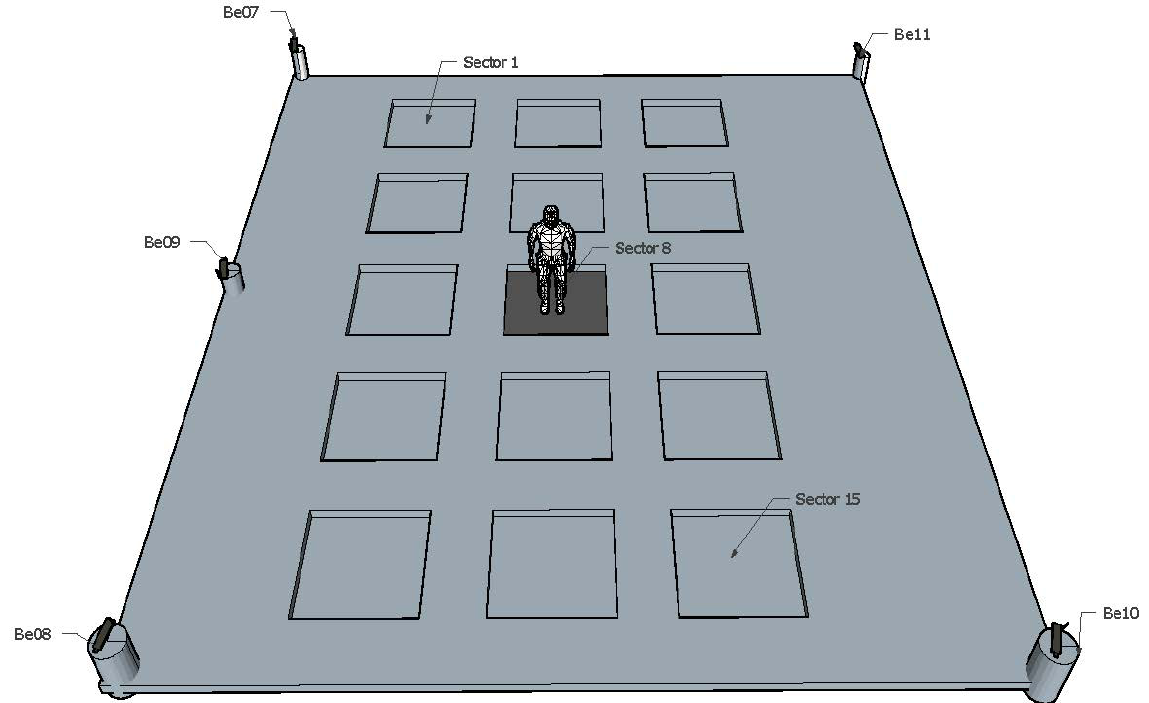
Figure 2. BLE4.0 beacon indoor localization